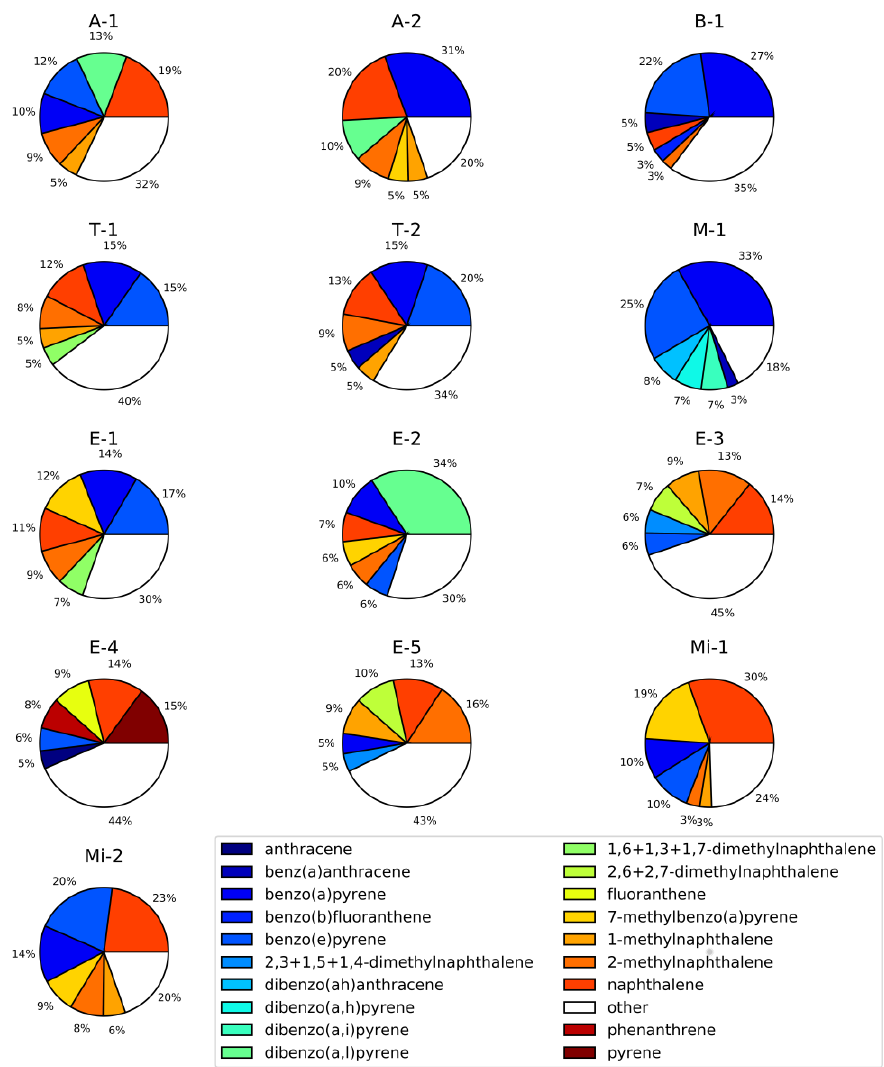
Figure 5. Top six PAHs that have highest BaPeq concentration levels in both gas and particle phases.